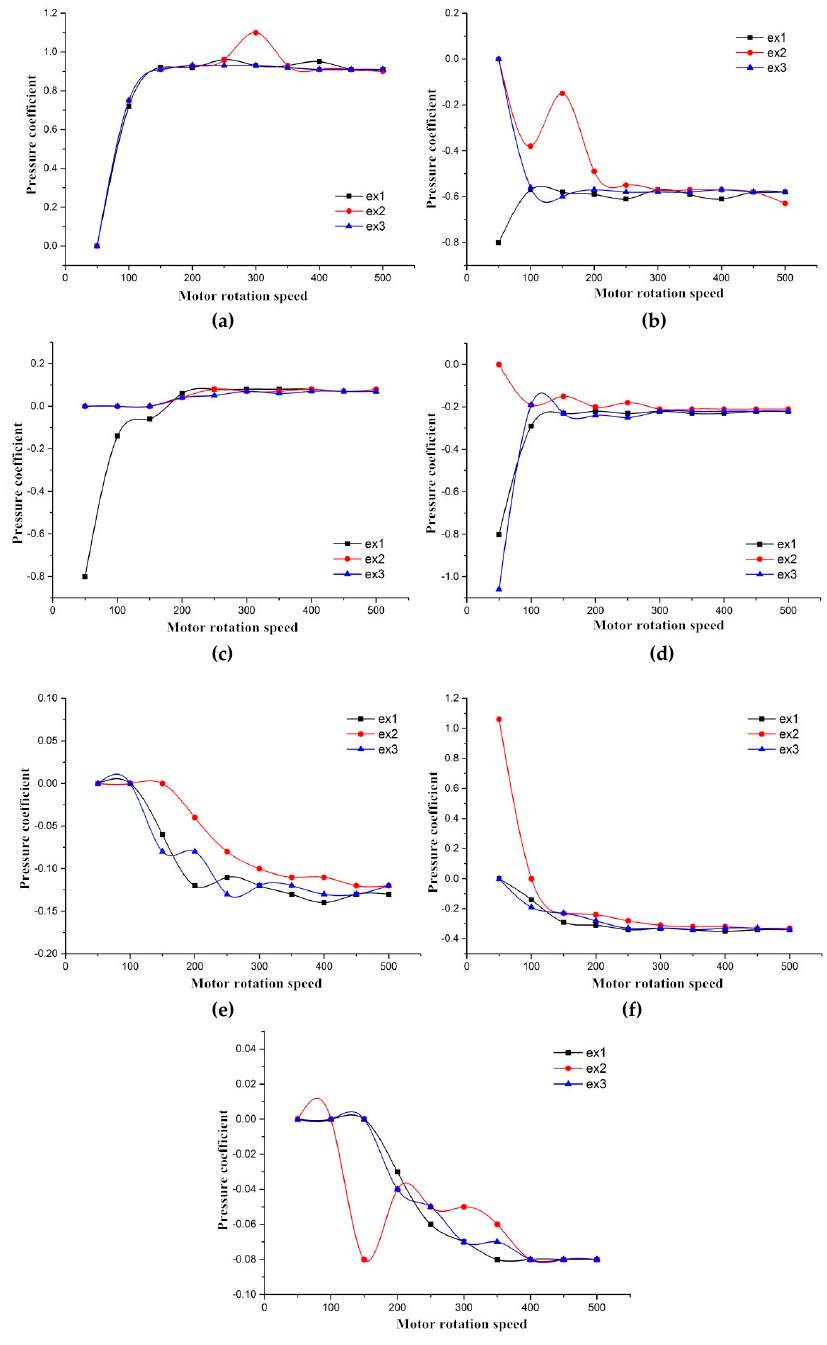
Figure 3. Motor rotation speed (MRS) and pressure coe ffi cient. ( a ) Pressure measuring hole d 1 ; ( b ) Pressure measuring hole d 2 ; ( c ) Pressure measuring hole d 3 ; ( d ) Pressure measuring hole d 4 ; ( e ) Pressure measuring hole d 5 ; ( f ) Pressure measuring hole d 6 ; and ( g ) Pressure measuring hole d 7